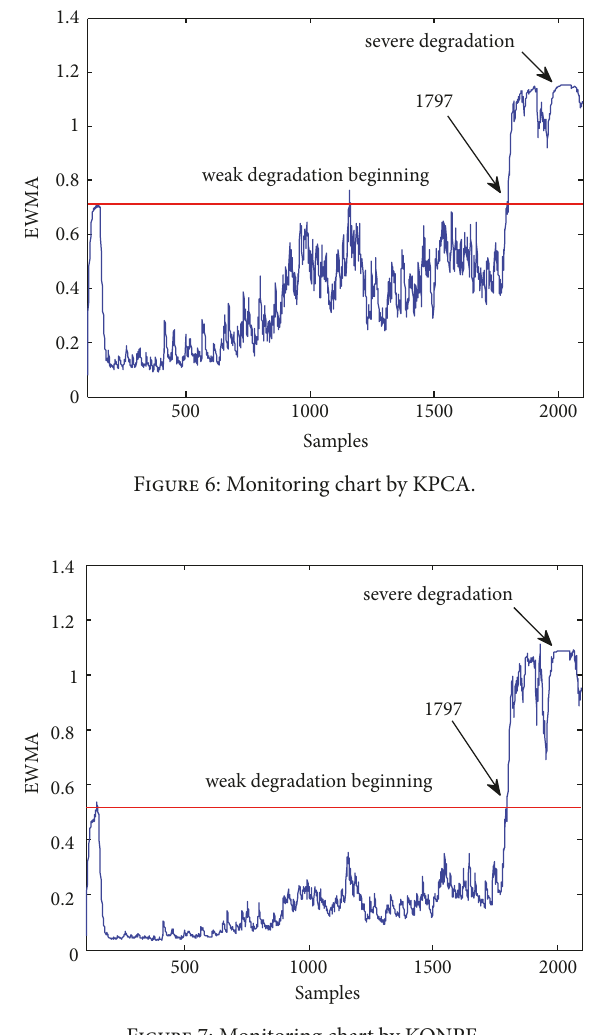
Figure 7: Monitoring chart by